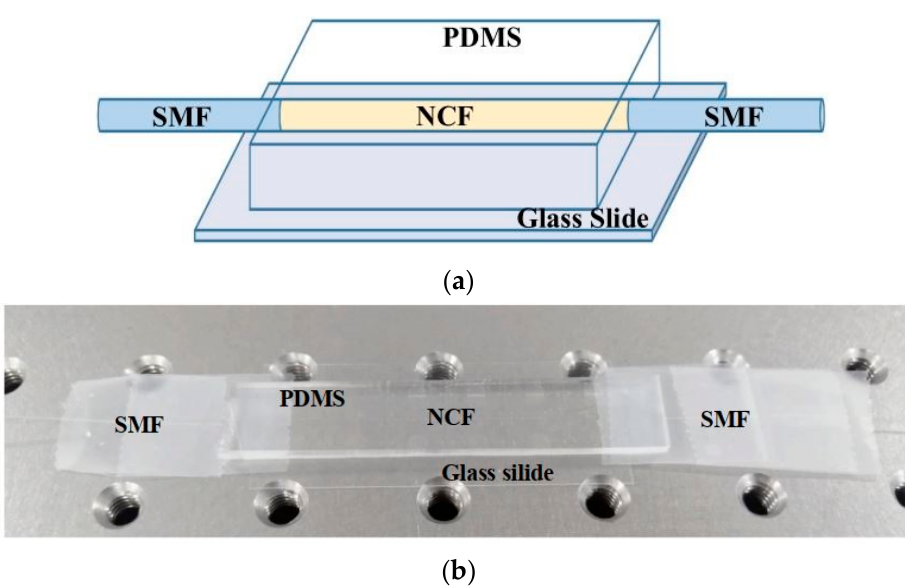
Figure 11. ( a ) Structural and ( b ) physical pictures of the sensor chip [18].